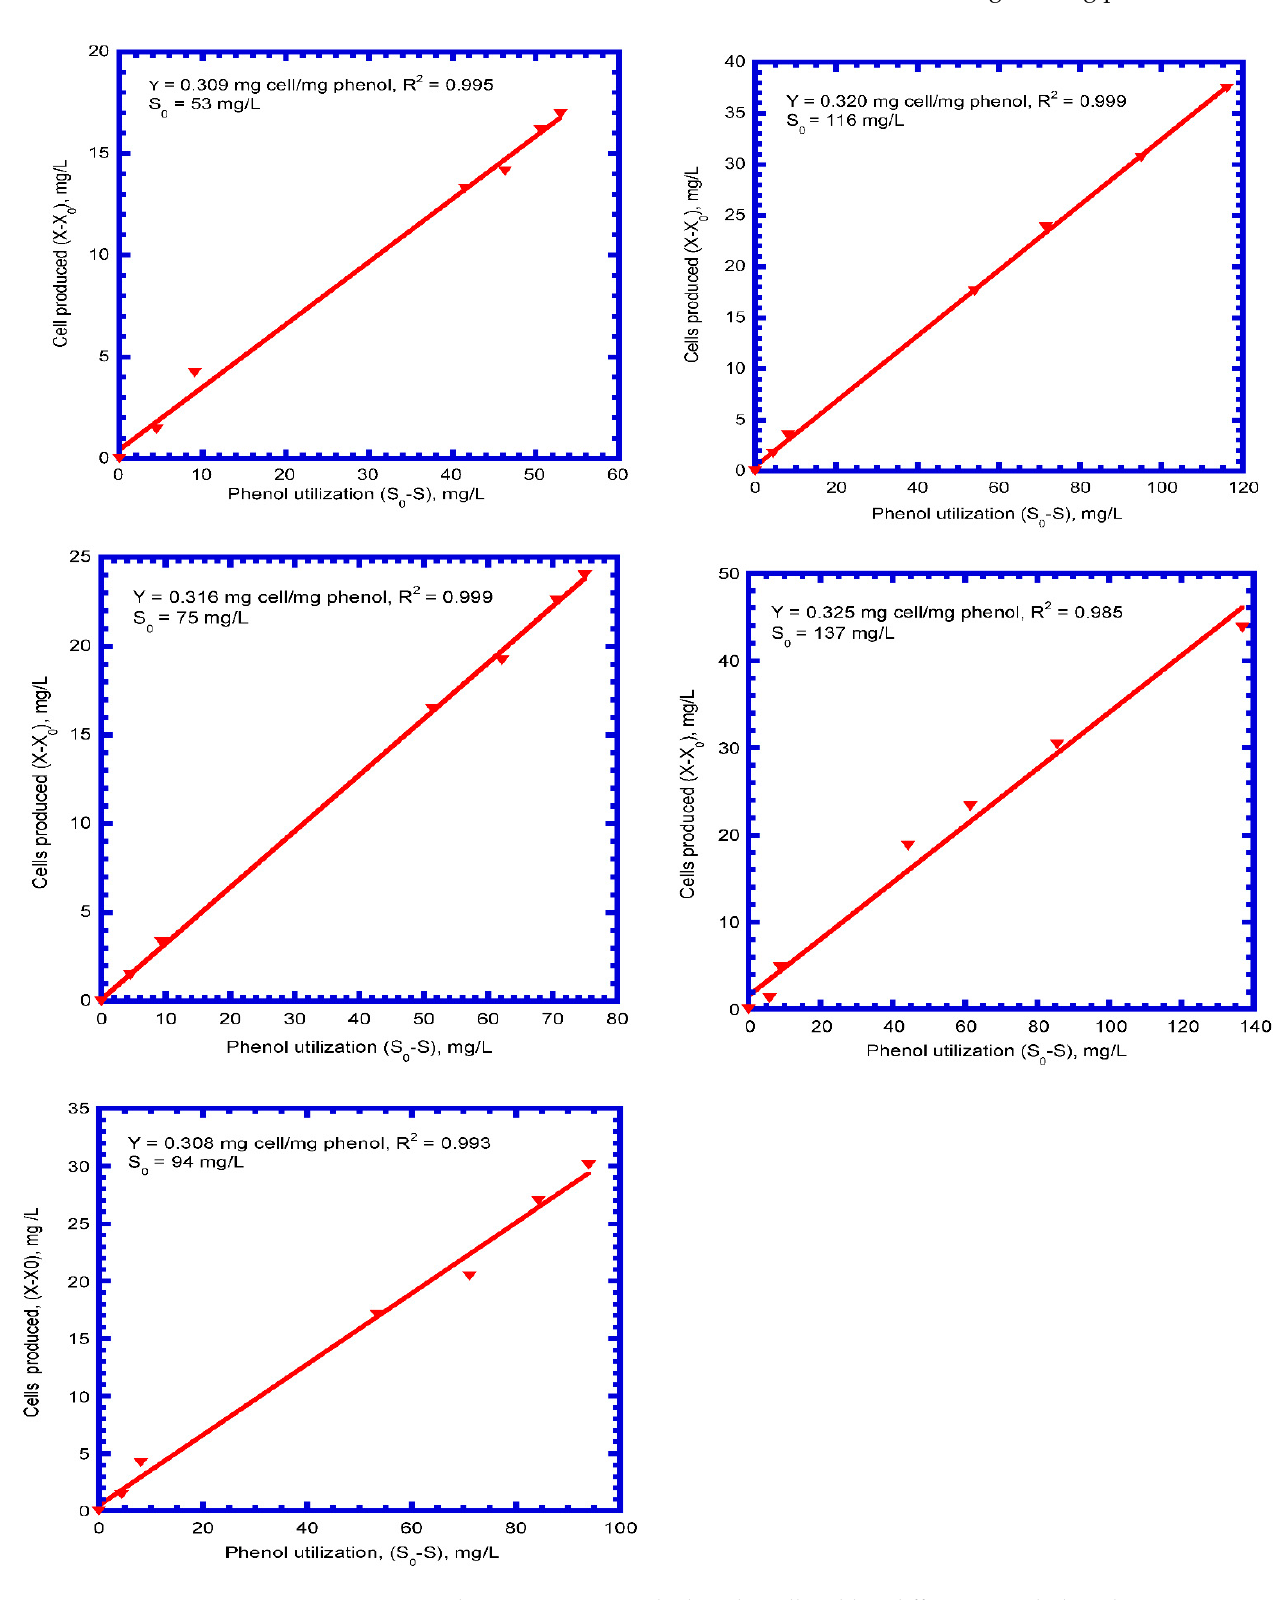
Figure 5. Batch experiments to calculate the cell yield at different initial phenol concentrations of 53–137 mg/L.